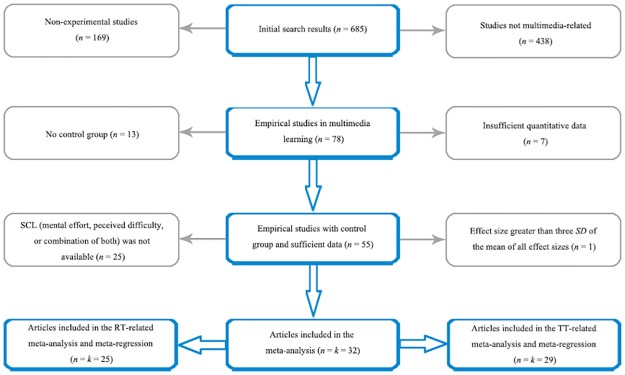
Flow chart of initial literature search and study selection process.Note. n = number of articles, k = number of effect sizes, RT = retention test, TT = transfer test.